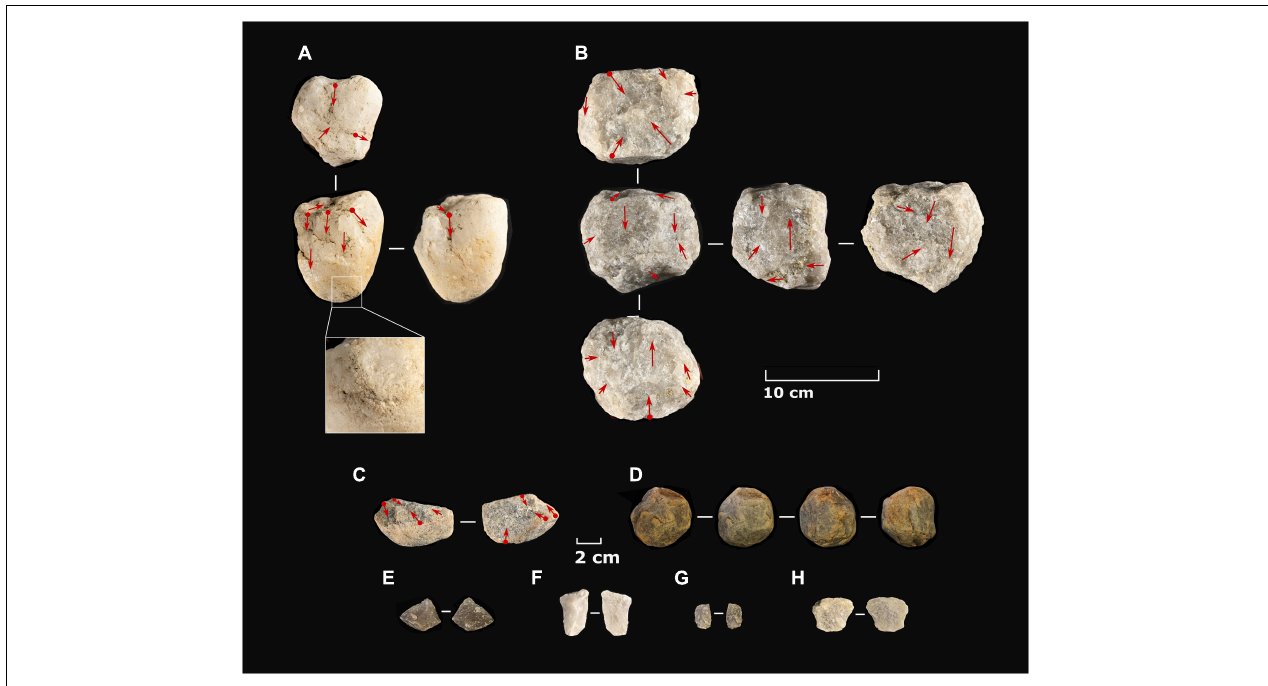
FIGURE 4 | Selection of stone tools from Phase III. (A) Quartzite bifacial orthogonal core with technical schemes. Detail shows impact marks on the surface. (B) Quartzite multipolar multifacial core with technical schemes. (C) Quartzite unifacial centripetal core with technical schemes. (D) Quartzite spheroid. (E–H) Quartzite flakes. Red arrows indicate the directions of flake’s